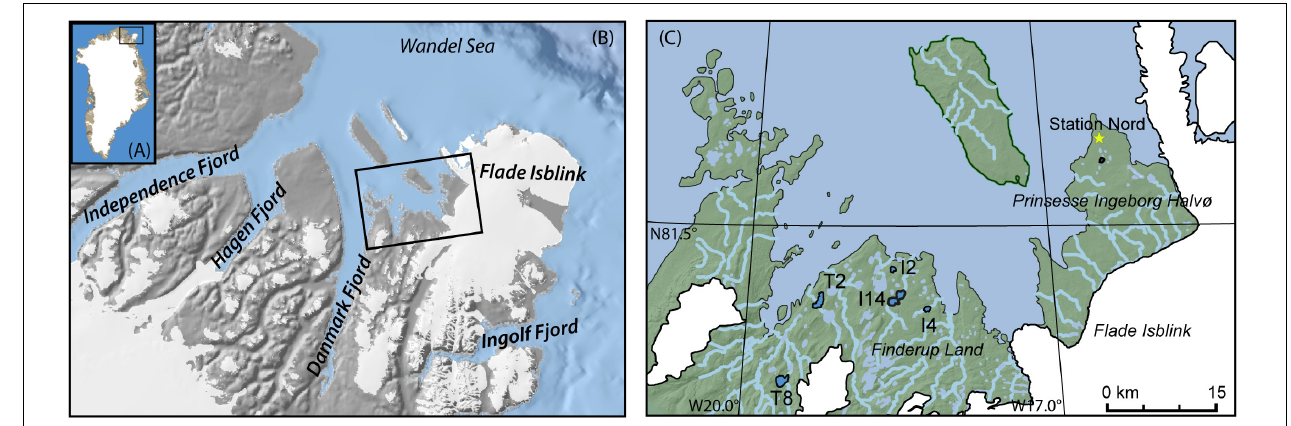
FIGURE 1 | (A) Greenland with marked location of the larger area surrounding Finderup land shown in (B) (black box). (B) The larger area around Finderup Land with black box marking our field area as shown in detail in (C) (black box). (C) Map of Finderup Land with locations of cored isolation lakes from this study (numbered) and Sommersø, 4 km south of Station Nord, cored by Funder and Abrahamsen